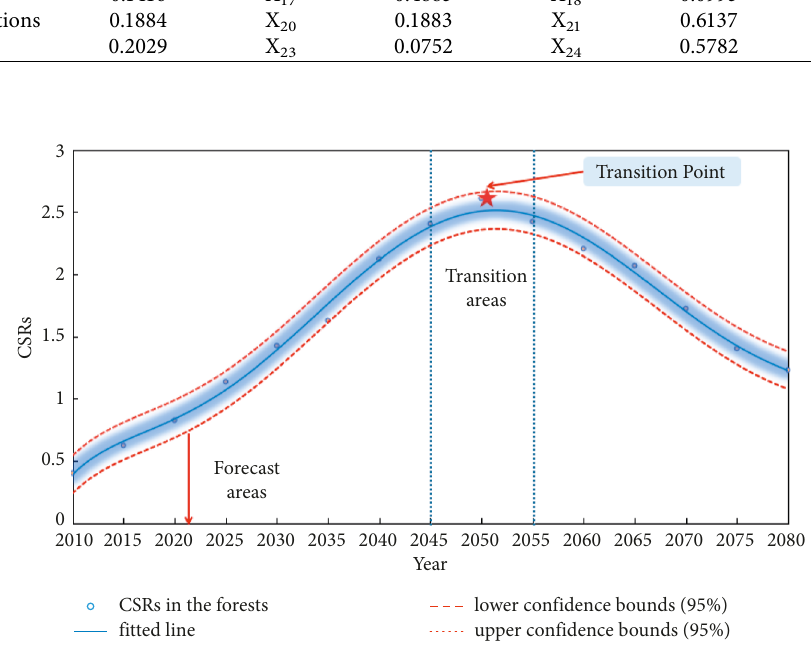
Figure 3: Fitting curve of available benefit data over